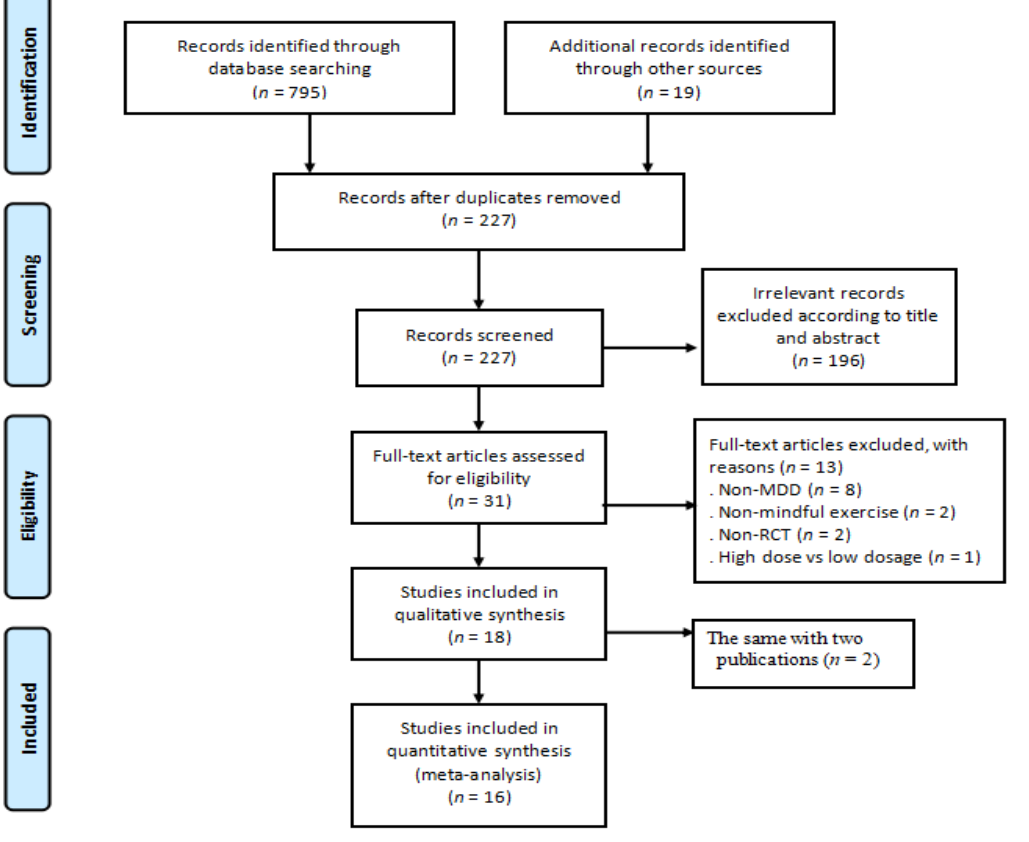
Figure 1. The detailed process of trial selection (MDD = major depressive disorder; RCT = randomized controlled).